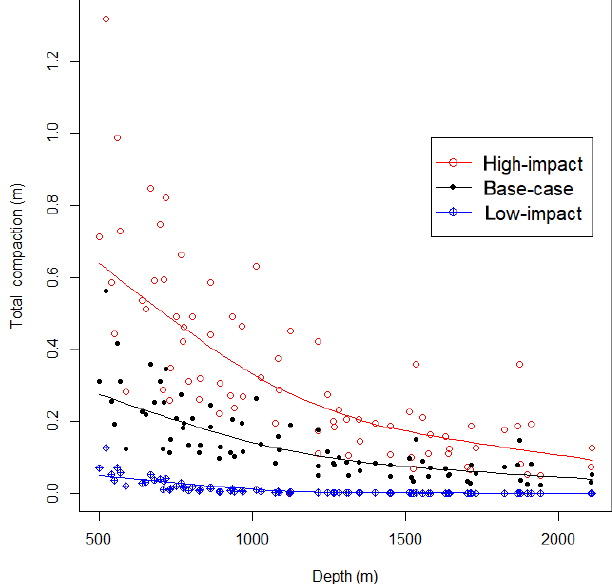
Figure 2. Simulated compaction as a function of depth after 10 years of production for the three sensitivity cases (see Table